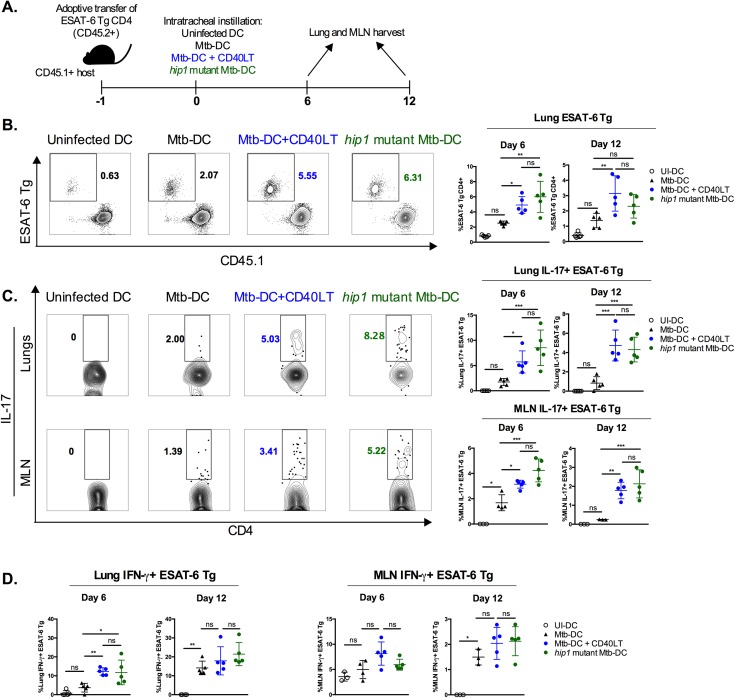
Enhanced antigen-specific Th17 responses in the lungs and MLN of mice following transfer of CD40LT-engaged Mtb-infected DCs or hip1 mutant Mtb-infected DCs.(A) Diagram of experimental design. As before, purified CD45.2+ ESAT-6 TCR Tg CD4 T cells were adoptively transferred 1 day before intratracheal instillation of DCs: uninfected DCs (UI-DC), Mtb-infected DCs (Mtb-DC), Mtb-infected DCs with CD40L trimer treatment (Mtb-DC + CD40LT), or hip1 mutant Mtb-infected DC (hip1 mutant-DC). Lungs and MLN were harvested 6 and 12 days post-intratracheal instillation and CD4 T cell responses assessed. (B) Representative flow plots (left; day 6 values) and summary graph (right) of the frequencies of CD45.2+ ESAT-6 TCR-Tg CD4 T cells in the lungs 6 and 12 days post-instillation. (C) Representative flow plots (left; day 6 values) and summary graphs (right) of the frequencies of IL-17+ ESAT-6 TCR-Tg CD4 T cells in the lungs (top) and MLN (bottom) after stimulation with ESAT-61−20 peptide (10 μg/ml). (D) Summary graphs of the frequencies of IFN-γ+ ESAT-6 TCR-Tg CD4 T cells in the lungs (left) and MLN (right) after ESAT-61−20 restimulation (10 μg/ml). Populations shown have been pre-gated on live CD3+CD8-γδ TCR-CD45.2+ singlets. 5 mice were used for each group. Statistical significance was determined using one-way analysis of variance (ANOVA) correcting for multiple comparisons. * p<0.05; ** p<0.005, *** p<0.0005, ns = not significant.